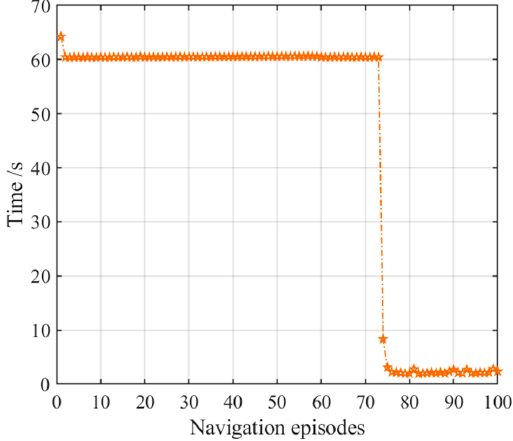
Figure 23. Navigation time with the NLM-HS when door B is closed. Orange pentagrams indicate the navigation time for each navigation episode.